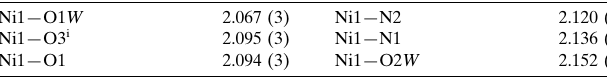
Selected bond lengths (A˚